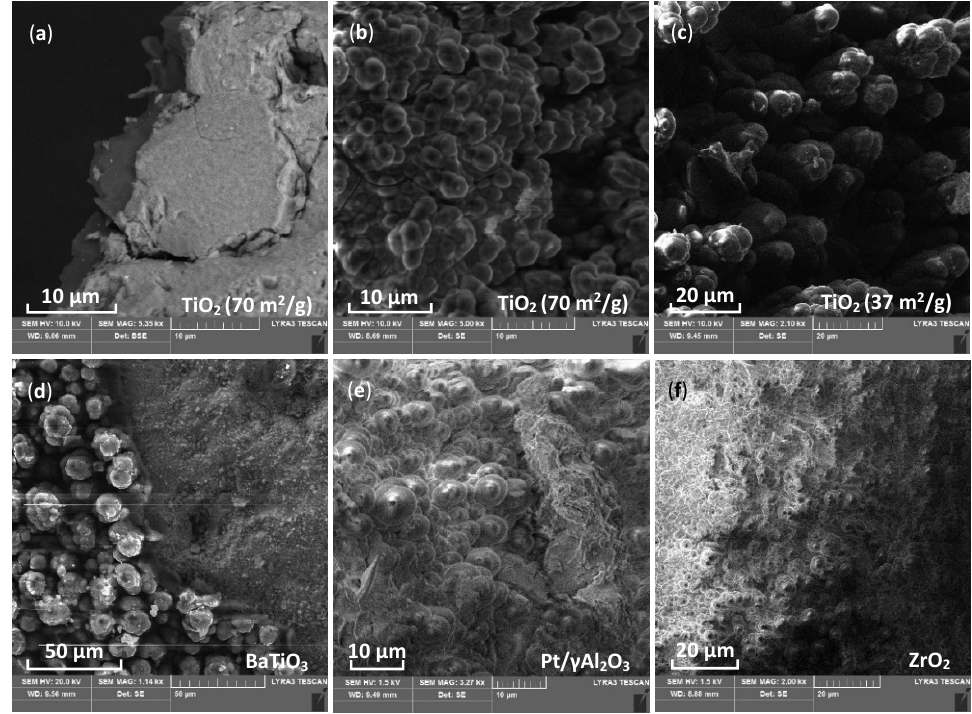
Figure 4. Detailed SEM images of ( a ) cross-sectional view of TiO 2 surface and ( b – f ) solid carbon deposits on surface of various packing materials. Note that different magnifications are used.